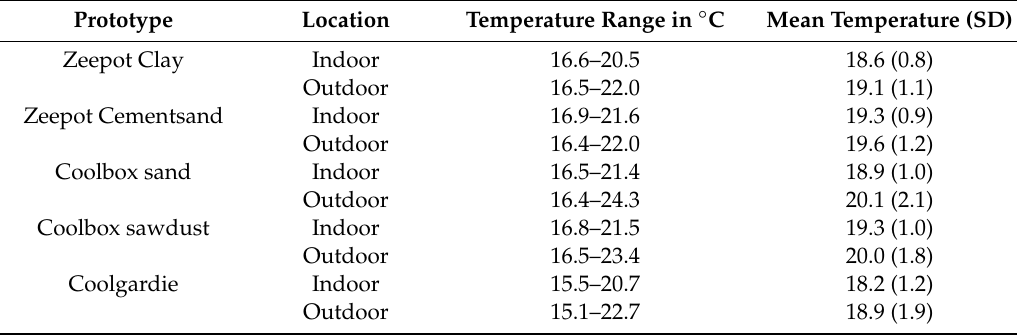
Table 2. Summary of the temperatures recorded within each PCD prototype during the initial 2-week testing